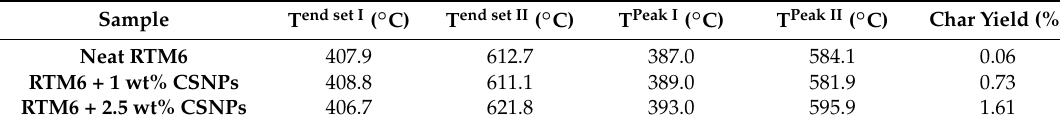
Table 2. Results of TGA tests (in air) for CSNPs/RTM6 systems.